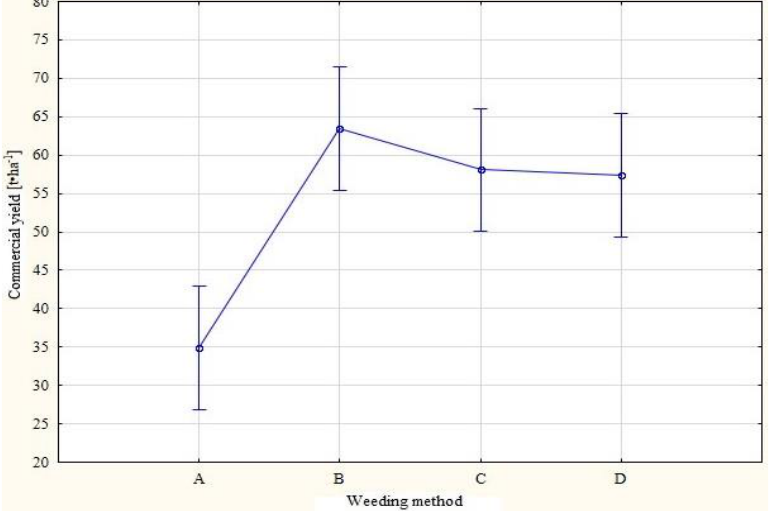
Figure 9. Expected marginal averages for 0.95 confidence intervals in commercial onion yield in 2017 (source: own work).